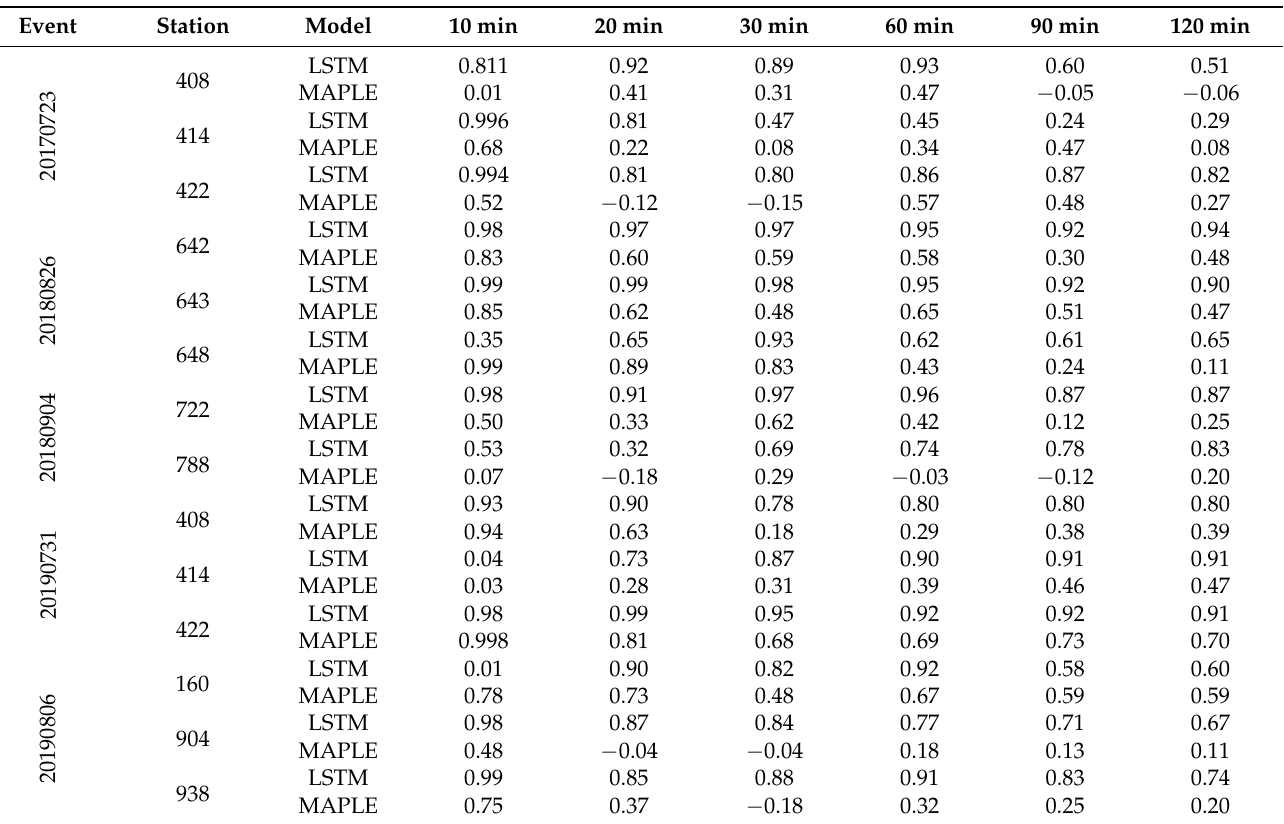
Table 3. Correlation coefficient of MAPLE and LSTM model within 120 min lead time at the stations in the five test events. The values of each station were estimated by averaging the values of QPFs in each event.